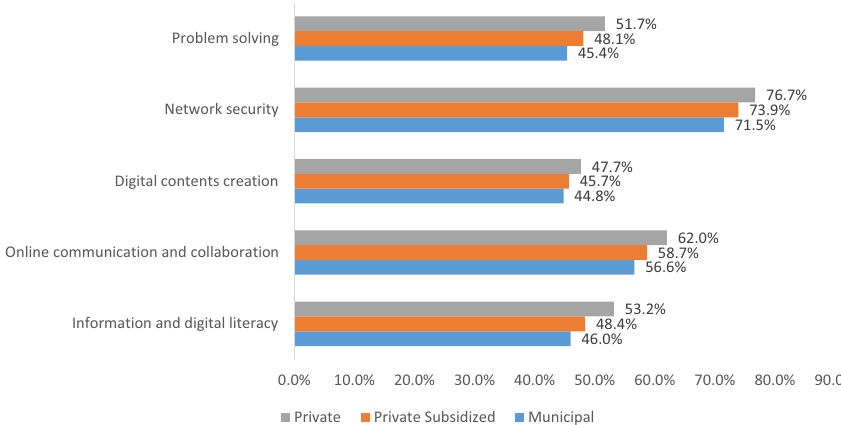
Fig. 4 Level of achievement in the areas of digital competence by type of institution